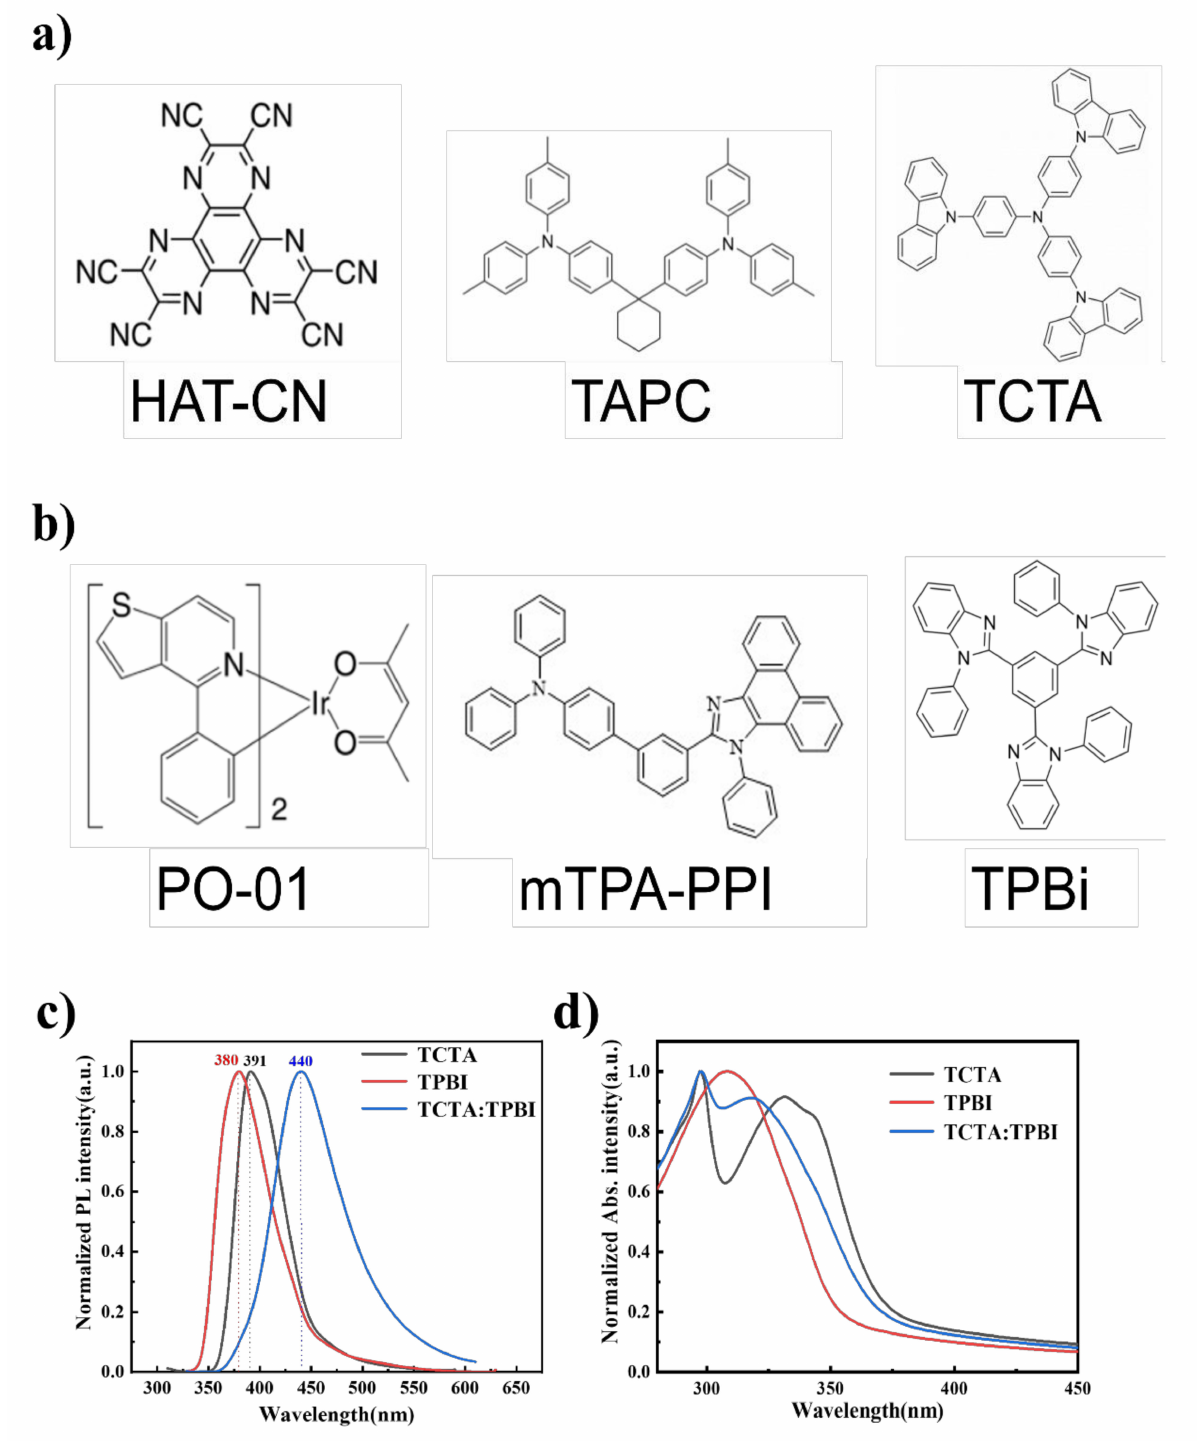
Figure 1. Molecular structures of organic materials used in this study ( a , b ), photoluminescence (PL) spectra ( c ), and Abs spectra ( d ) of 4,4,4-tris (N-carbazolyl) triphenylamine (TCTA), 1,3,5-tris (N-phenylbenzimidazol-2-yl) benzene (TPBI), and TCTA:TPBI